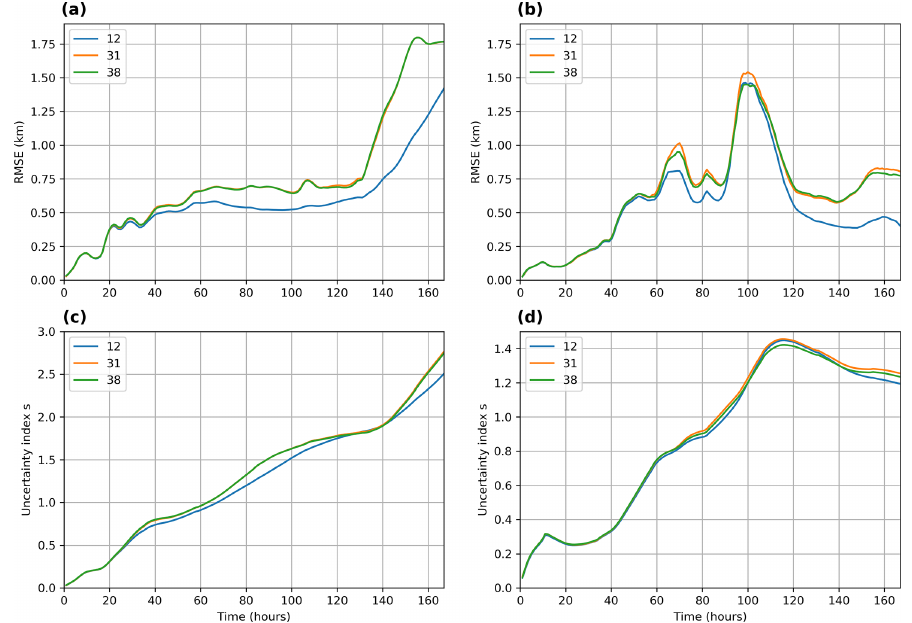
Figure 10. RMSE (km) for (a) winter and (b) spring as a function of the forecast time. Uncertainty index s (no units) for (c) winter and (d) spring. Oil types: API 12, 31, and